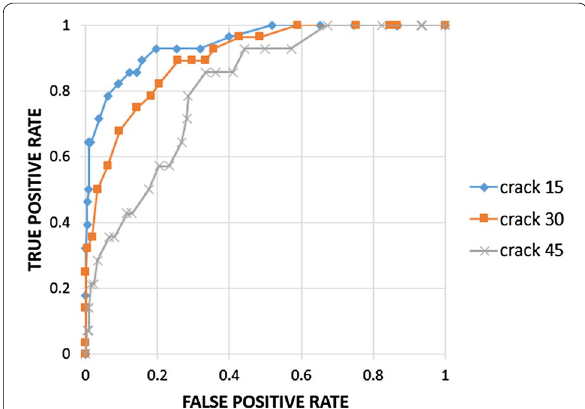
Fig. 7 ROC curve for the delamination type blocks. Higher values of delamination inclination means deeper defects and therefore less audible, recordable sounds. This causes a drop in performance in pair with the inclinaison of the delamination. However, considering the still high efficiency for delaminations up to 45° and knowing that the vast majority of field-found delamination falls in this range, our proposed method can be considered satisfying